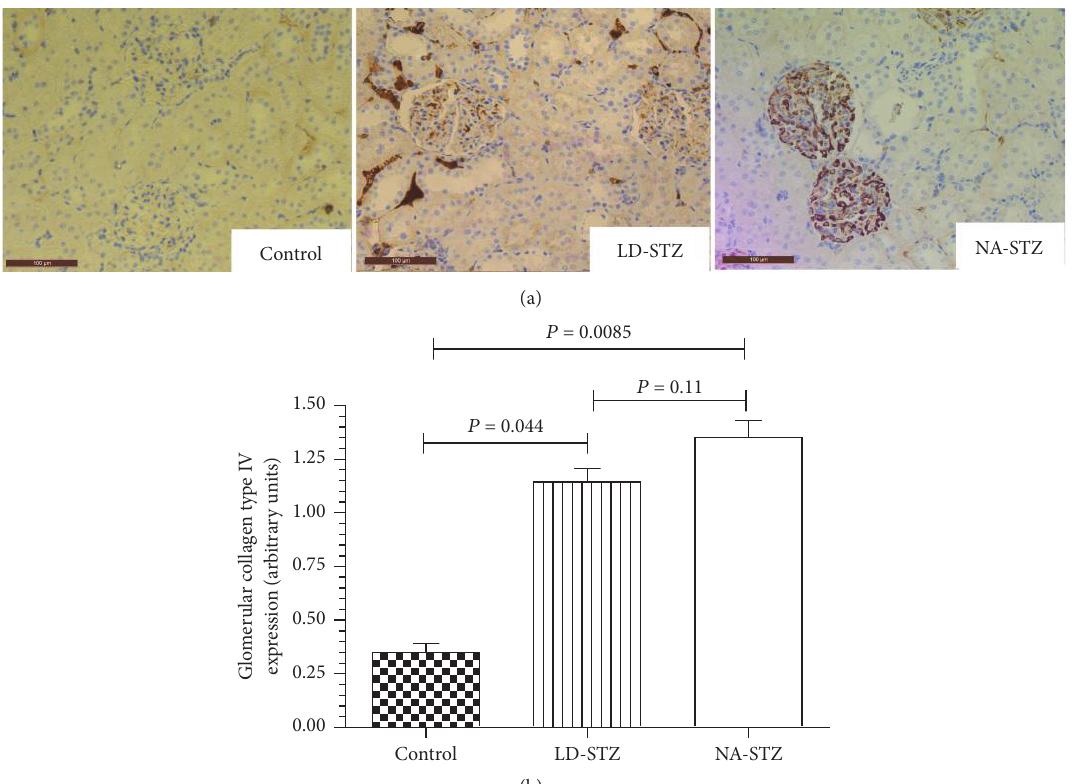
Figure 13: Immunostaining of kidney cortex sections from control and diabetic rats with anti-type IV collagen antibodies. (a) Representative microphotographs from the experimental groups (magnification × 320). The markedly increased immunostaining is present in glomerular basementmembranesandmesangialmatrixofbothdiabeticgroupsascomparedtocontrolnondiabeticrats.(b)Comparisonofthequantified stainingintensityinglomeruliofthestudiedgroups.ExpressionoftypeIVcollagenwasassessedsemiquantitatively.Meanvaluesandstandard deviations are